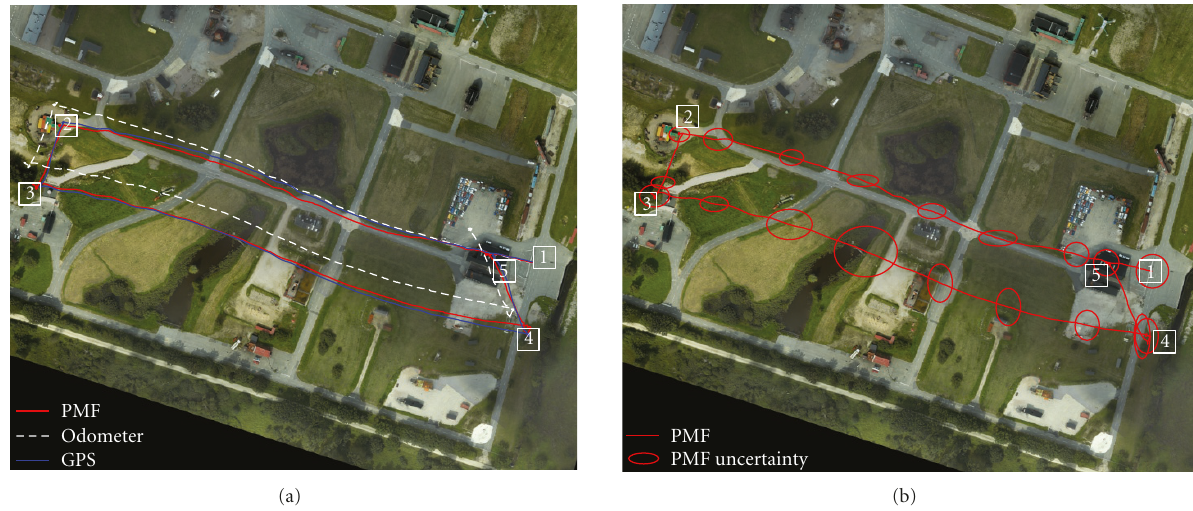
Figure 9: (a) displays the comparison between the flight path computed with the point-mass filter (red), the odometry (dashed white), and the GPS reference (blue). (b) shows the PMF result with the position uncertainty squared represented with ellipses along the path.